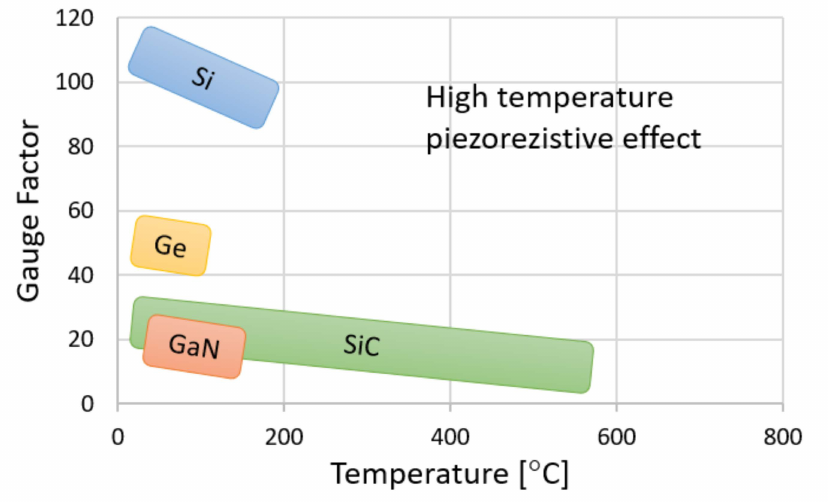
Figure 1. Effect of temperature on the piezoresistive gauge factor for typical semiconducting materi- als [4]. © 2015